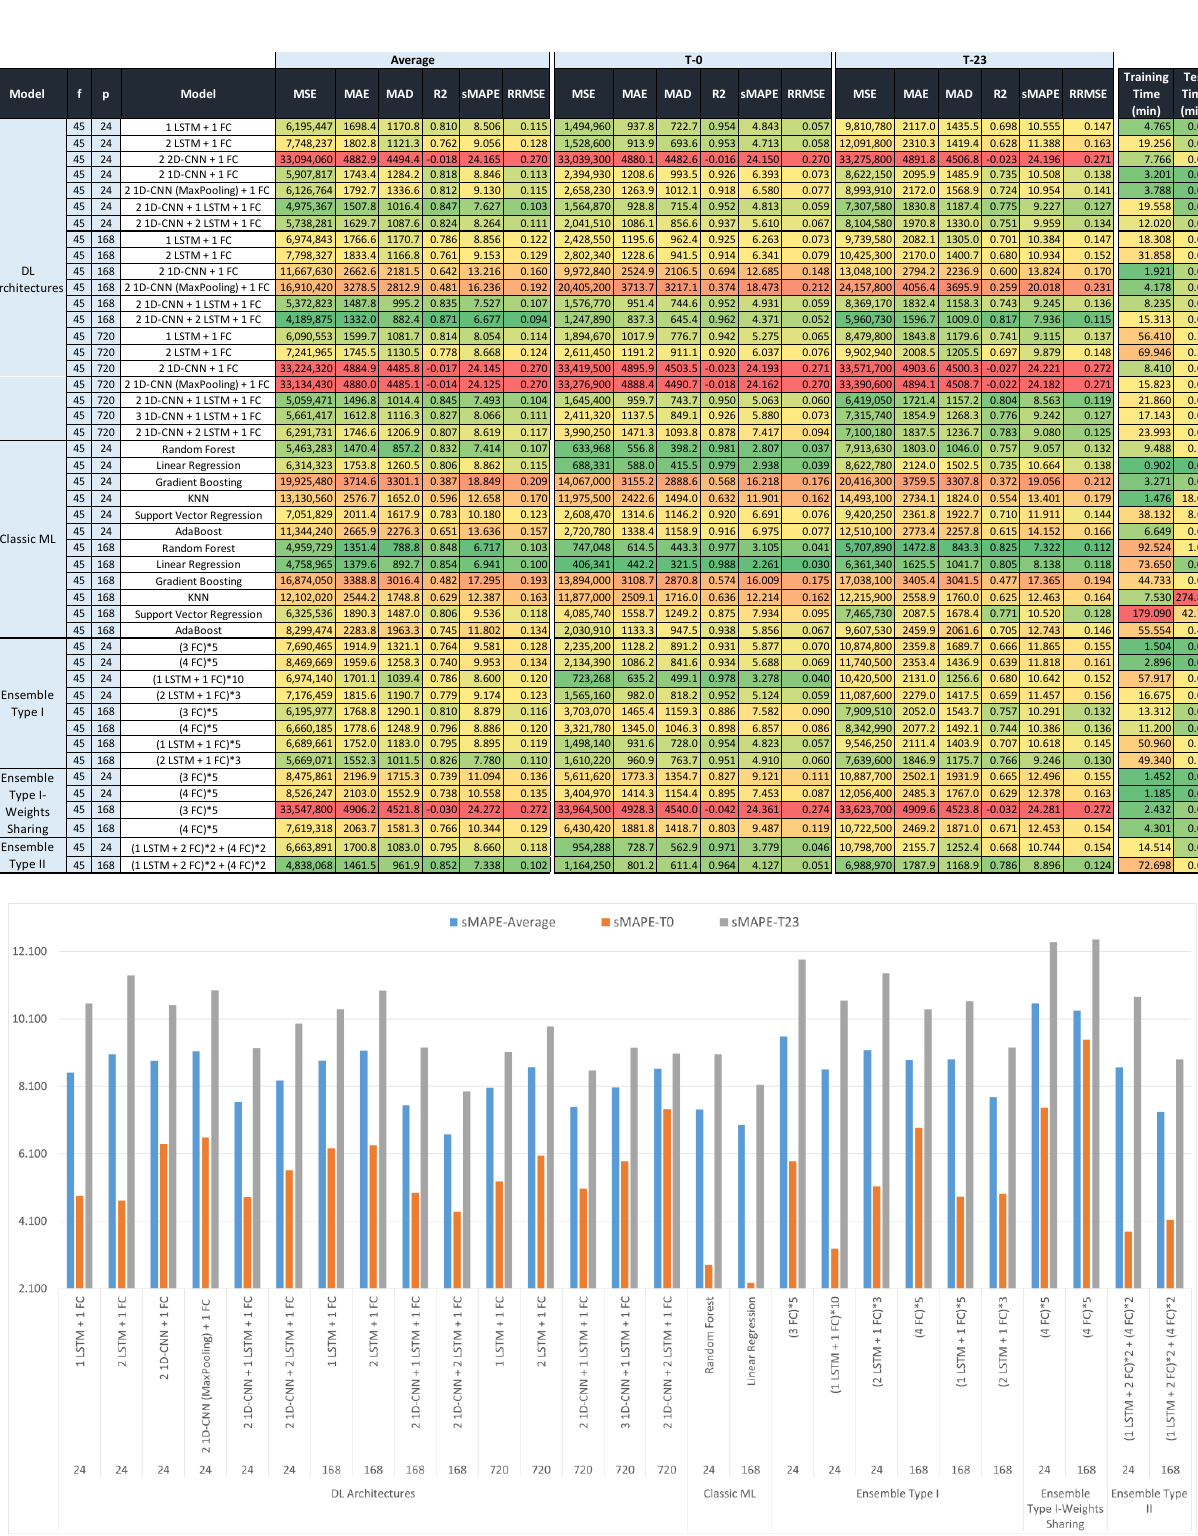
Figure 7. ( Upper section ): forecast metrics for the average, first (T-0), and last (T-23) predicted time-slots using DL, ML, and ensemble models for a fixed number of values per predictor ( f = 45). The table is color-coded along columns with colors between red and green corresponding to the worst and best results, respectively. ( Lower section ): bar chart for sMAPE metrics for some of the best performing models from the upper table.